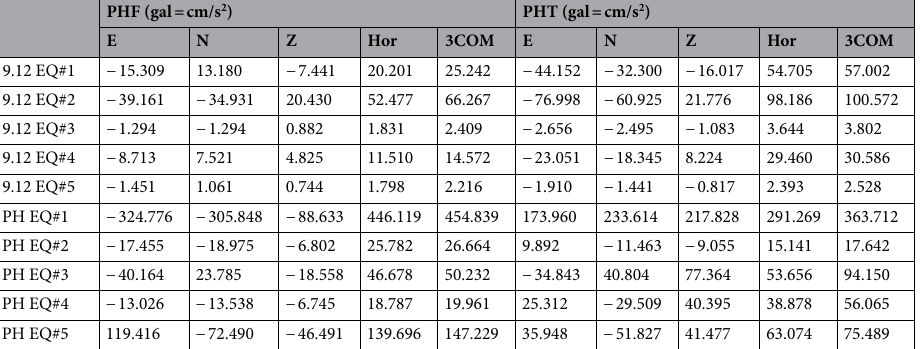
Table 4. Peak ground acceleration according to the station.